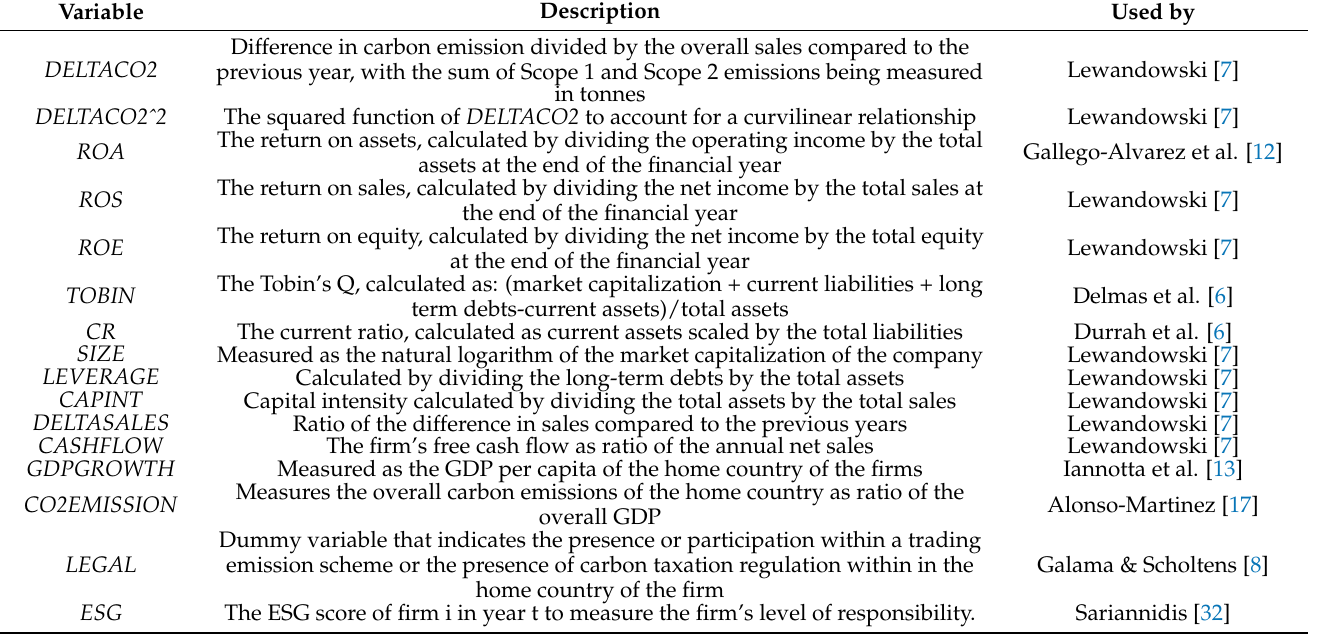
Table A1. Overview of